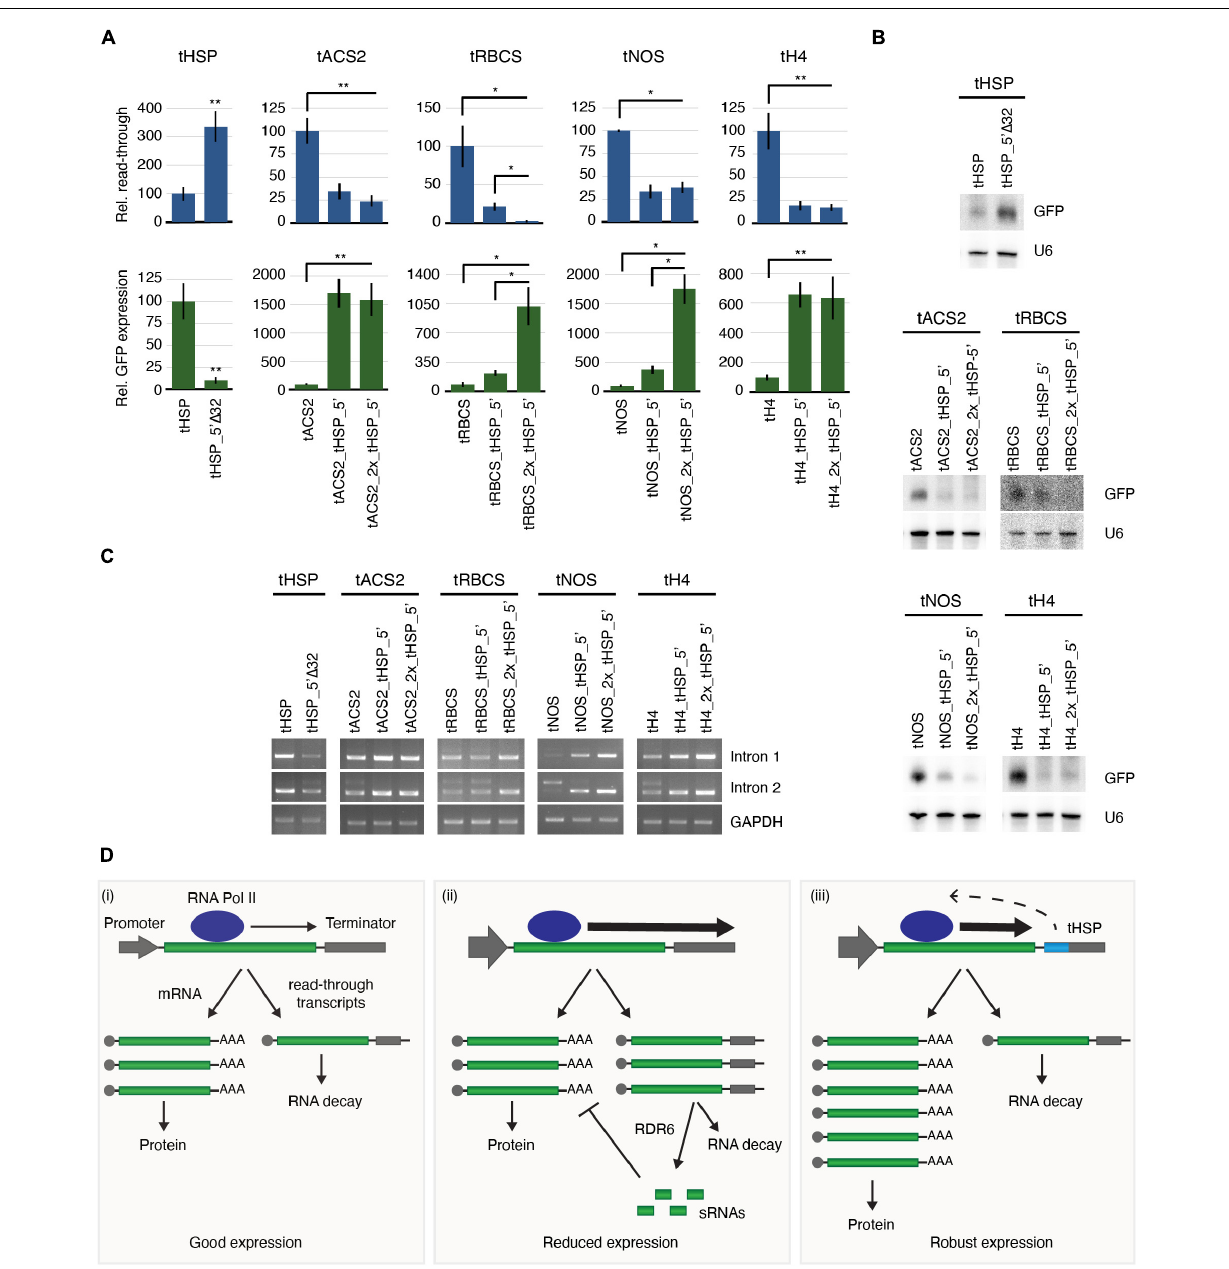
Frontiers in Plant Science |